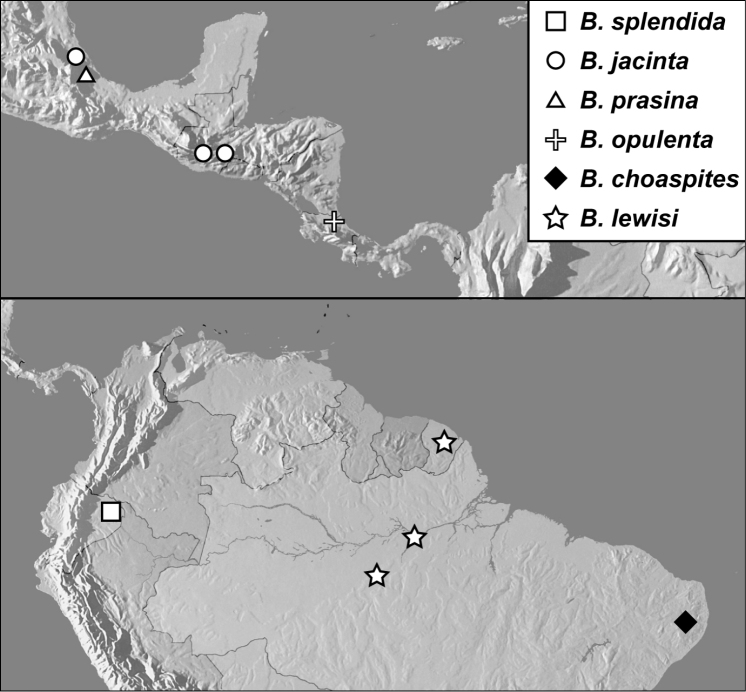
Baconia godmani group records.